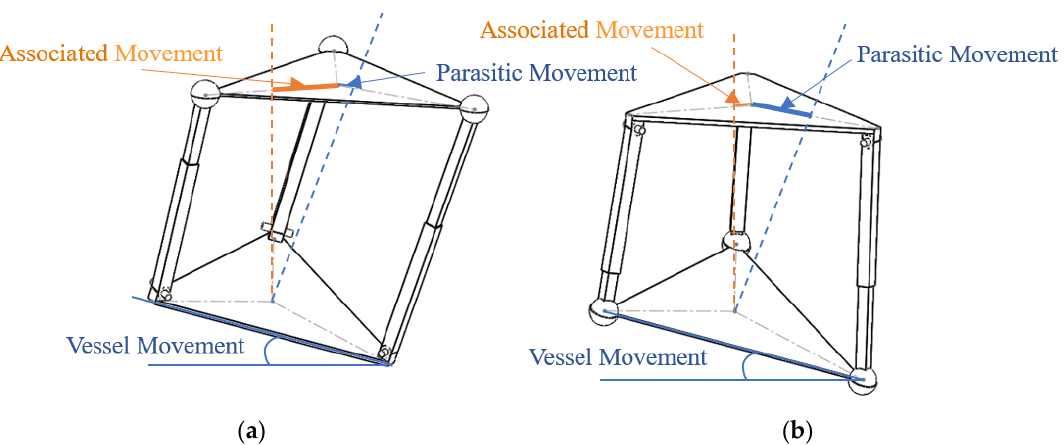
Figure 12. Compensation effect comparison; ( a ) is the compensation effect of the 3-RPS compensation platform; ( b ) is the compensation effect of the 3-SPR compensation platform.